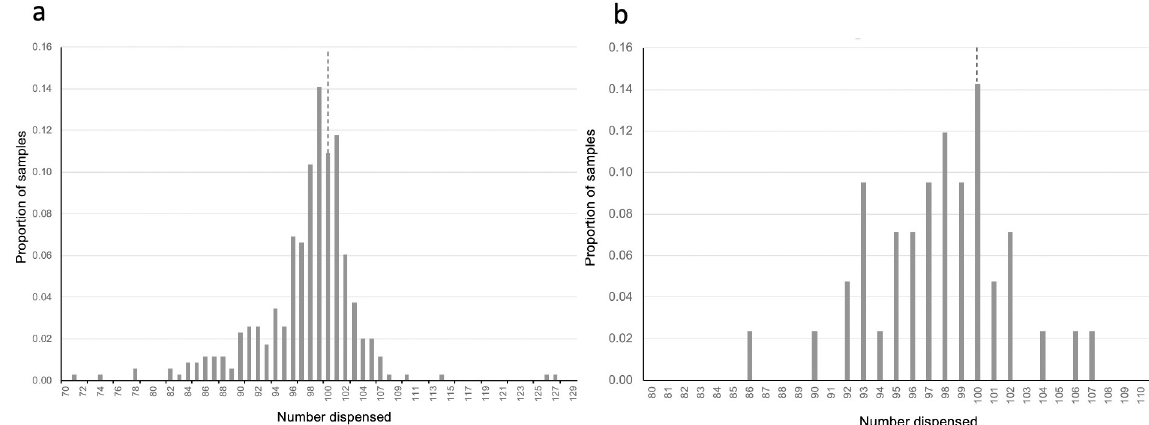
Fig 4. Precision of dispensing. The proportion of samples of various amounts dispensed when the target number was 100, indicated by the vertical dashed line. (a) The proportions of An . gambiae samples excluding two outlier samples with values of 40 and 141, consisting of a proportion of 0.003 of the samples. (b) The proportion of the number of samples of Ae . aegypti dispensed when the target number was 100.